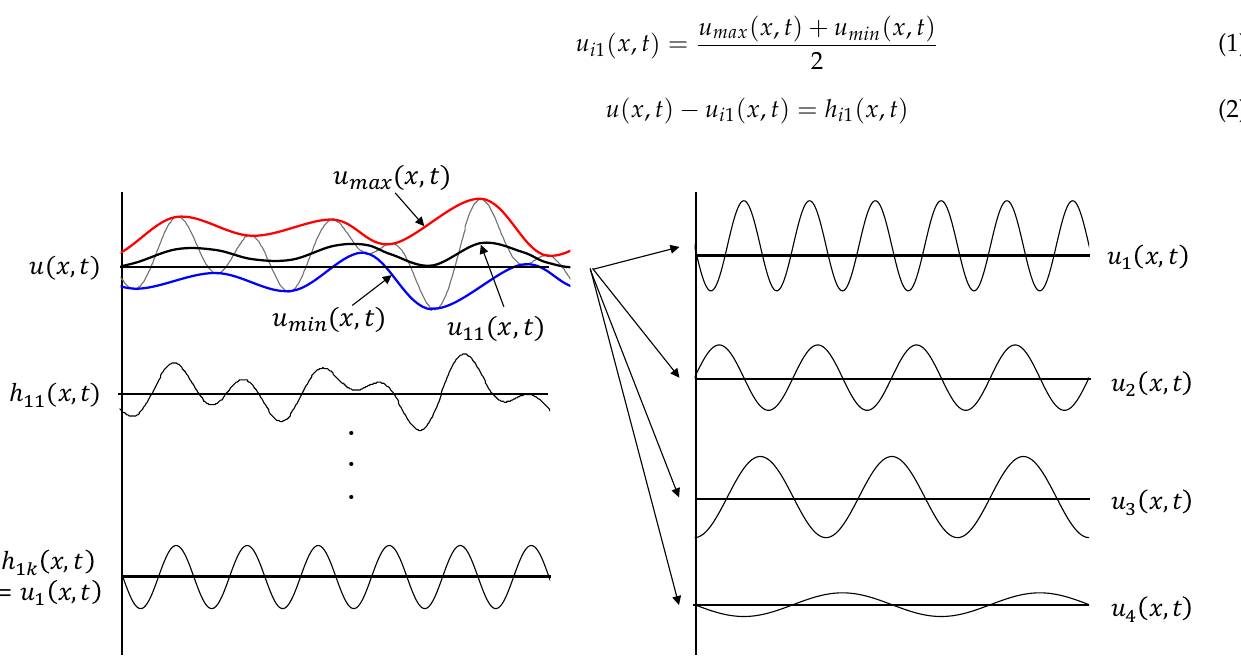
Figure 1. Procedure for extracting IMF using EMD.